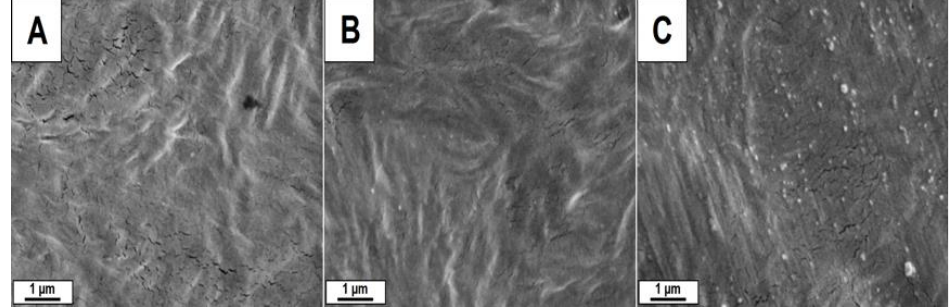
Figure 2. SEM micrographs of ( A ) HDPE, ( B ) HDPE.Cl.0500, and ( C ) HDPE.MeS.0500 (scale bar = 1 μm).